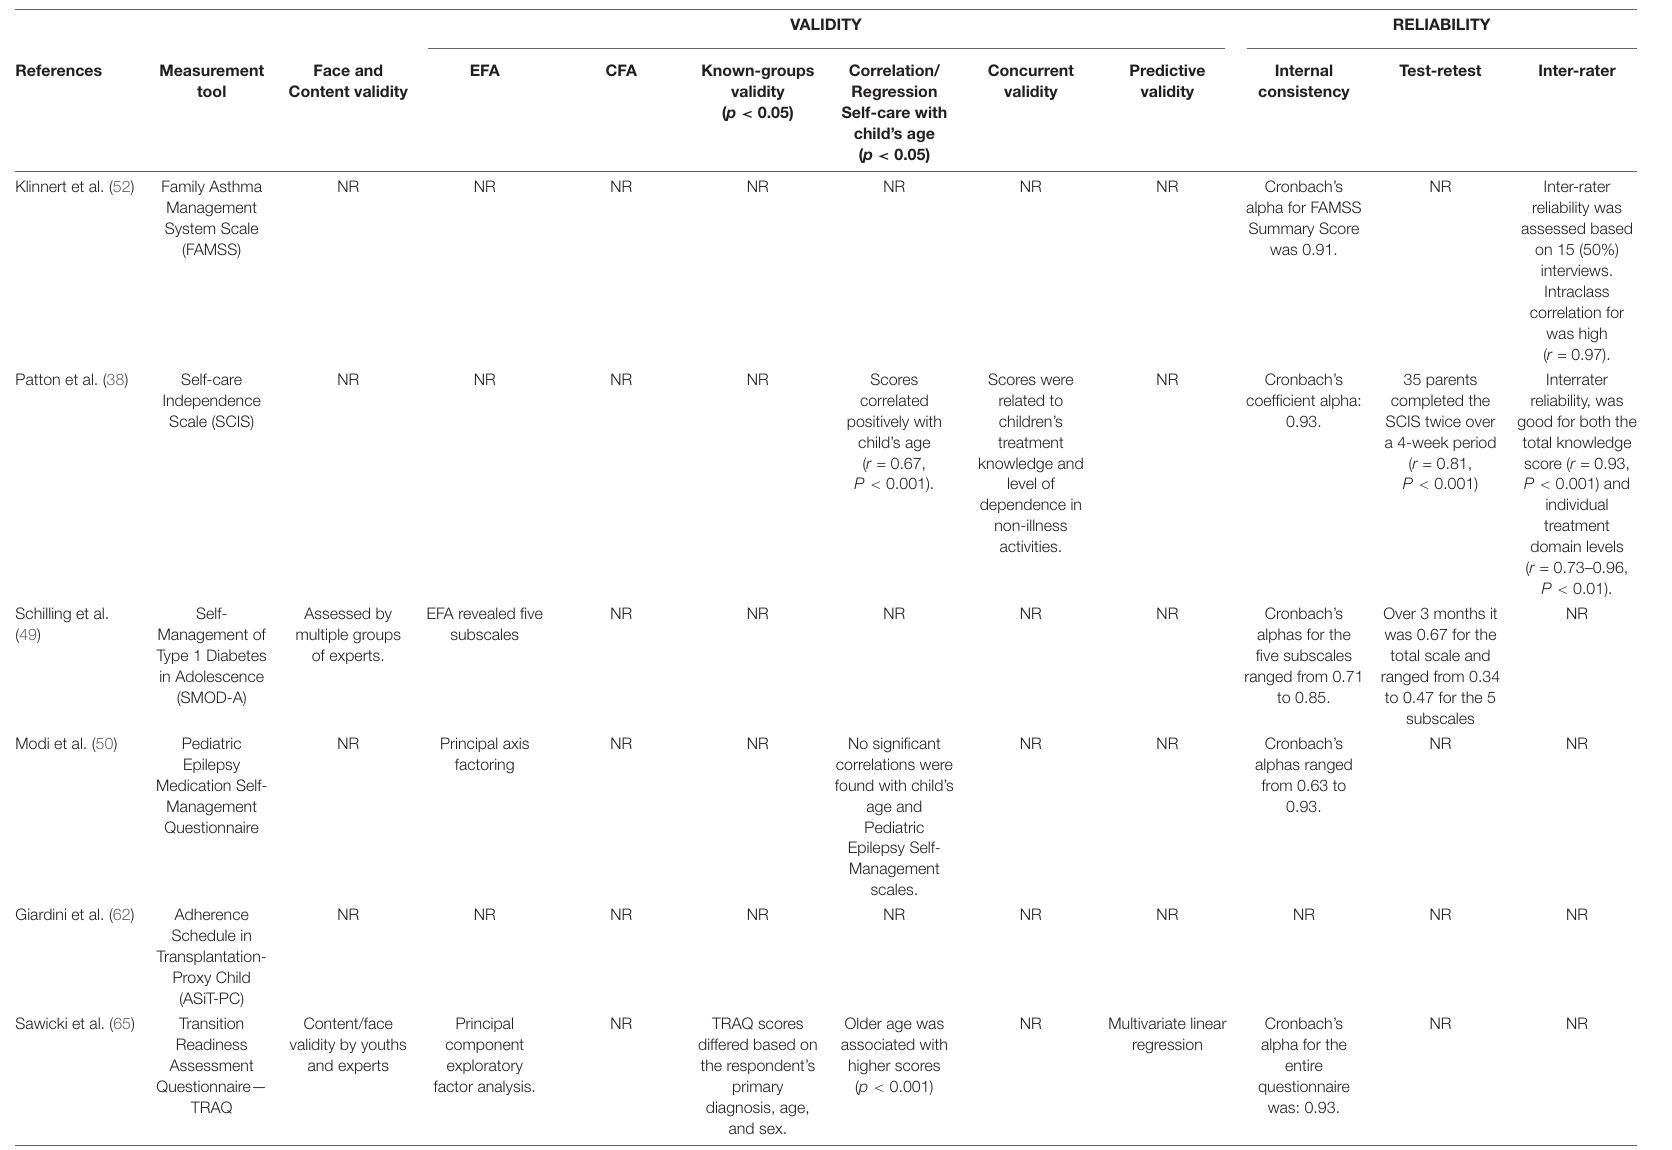
TABLE 3 | Psychometric characteristics of the self-care